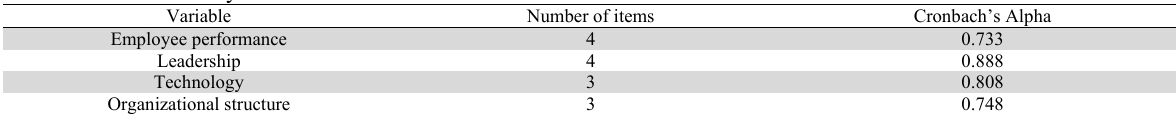
The results of Reliability Statistics